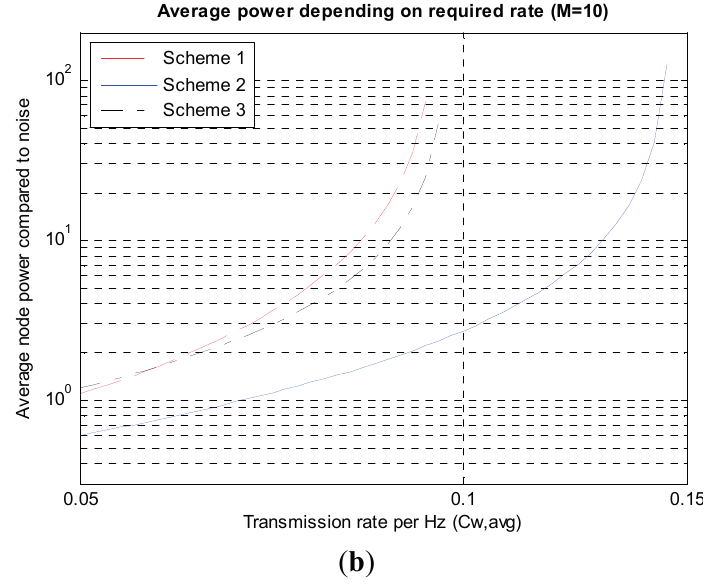
Figure 8. Average power depending on the transmission rates. ( a ) Wide range; ( b ) High rate range.